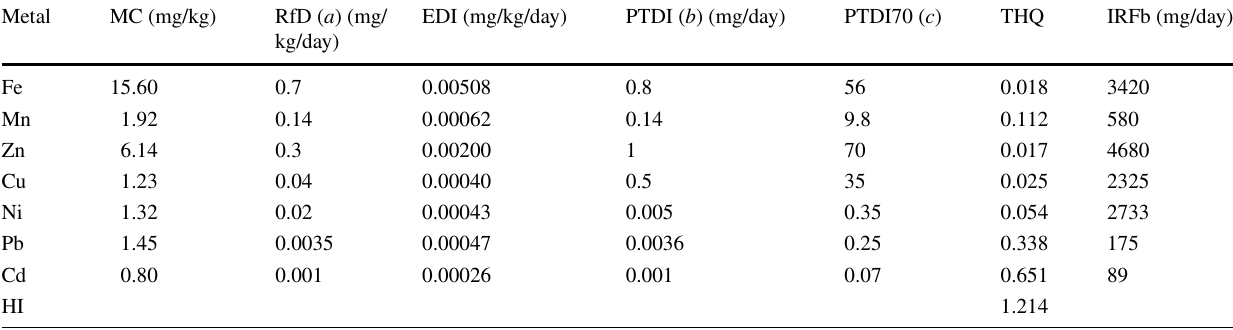
Table 9 Estimated daily intake (EDI) and target hazard quotient (THQ) values of the studied heavy metals due to consumption of muscles of Oreochromis niloticus collected from Mariout Lake